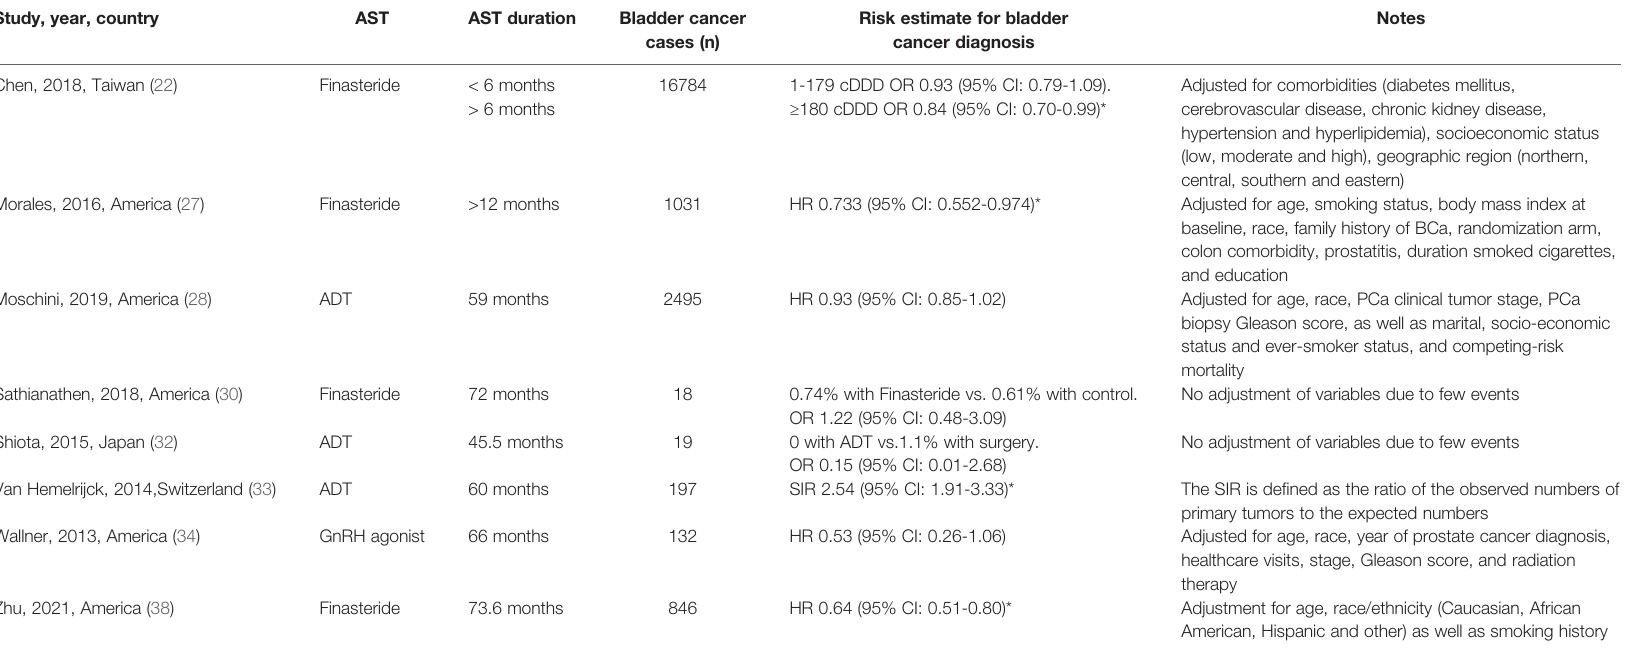
TABLE 2 | The effect of androgen suppression therapy on bladder cancer